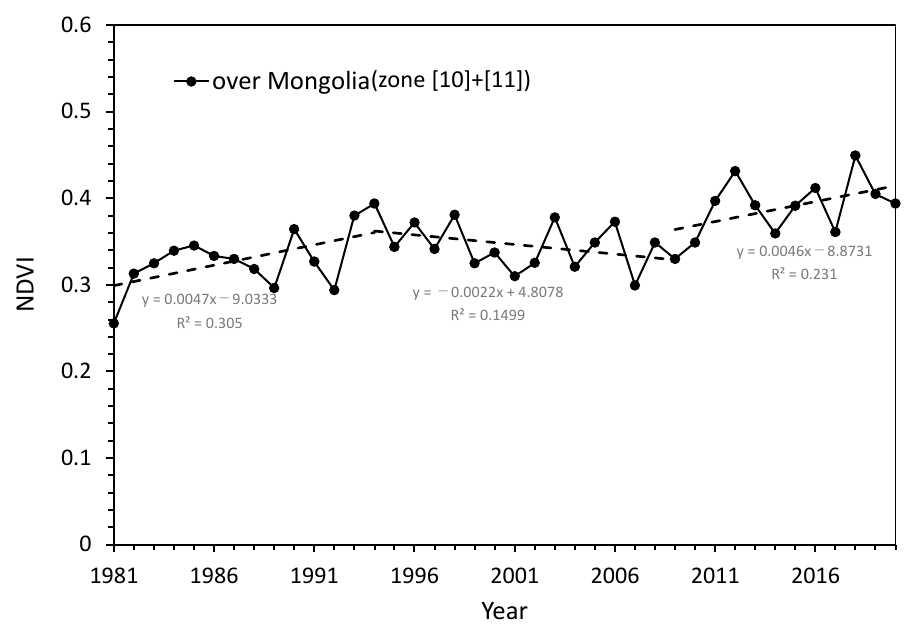
Figure 7. Annual changes (1981–2020) of the NDVI max in August over Mongolia. Dashed lines show the trends from 1981–1994, 1994–2009, and 2009–2020.